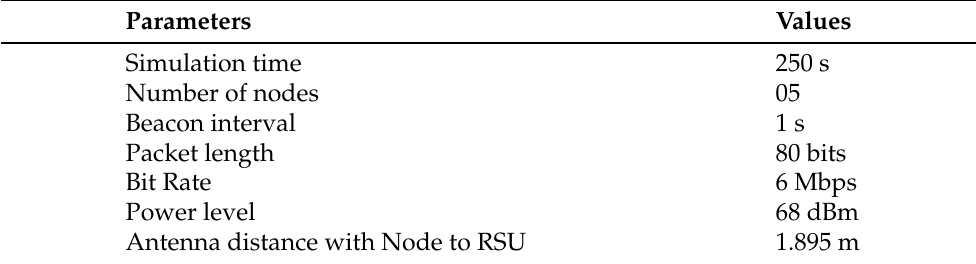
Table 5. Simulation